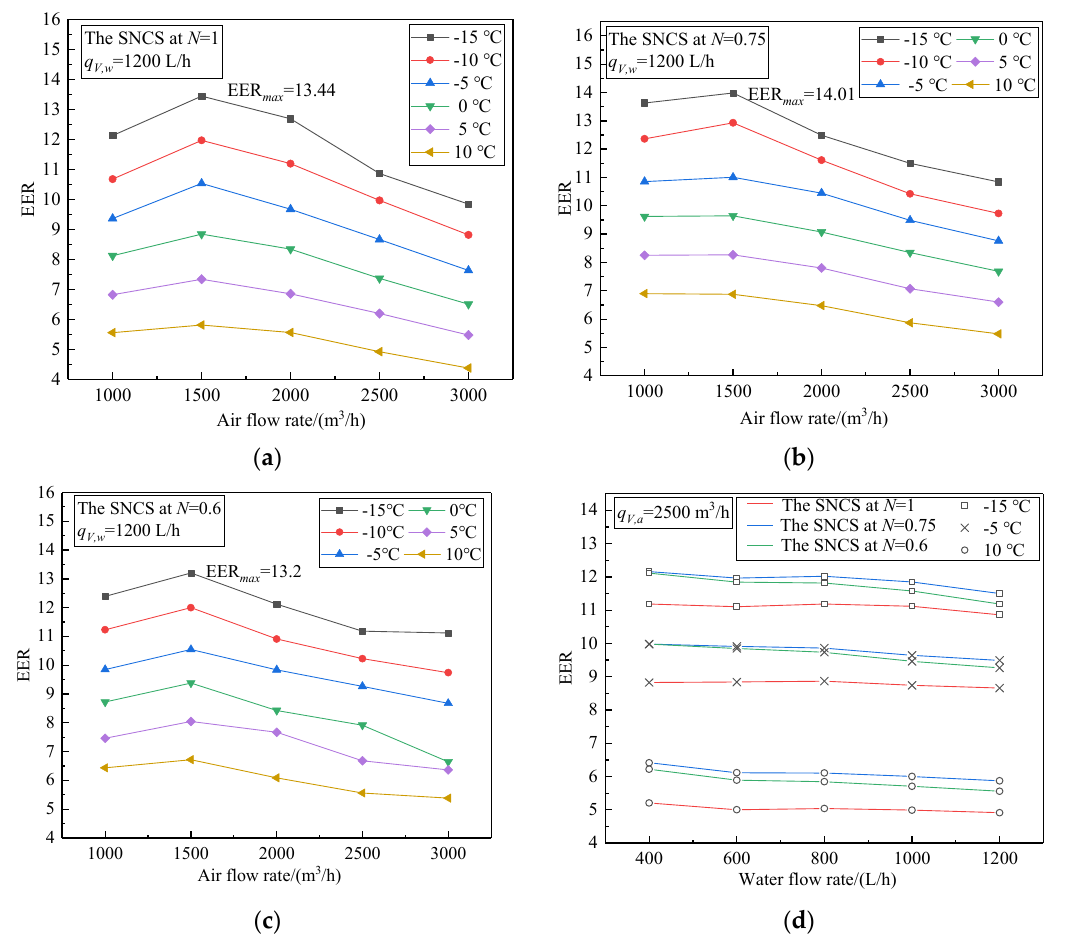
Figure 15. EER of the SNCS at different N under different air and water flow rates: ( a ) SNCS at N = 1; ( b ) SNCS at N = 0.75; ( c ) SNCS at N = 0.6 and; ( d ) under different q V , w .